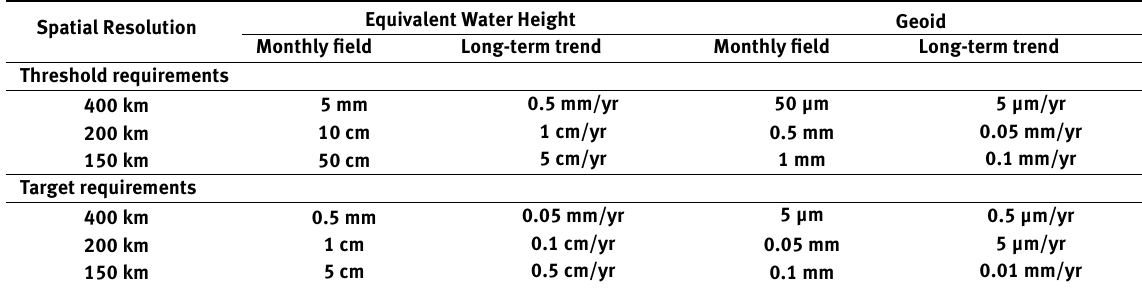
Table 1. MOBILE threshold and target science requirements and user needs.